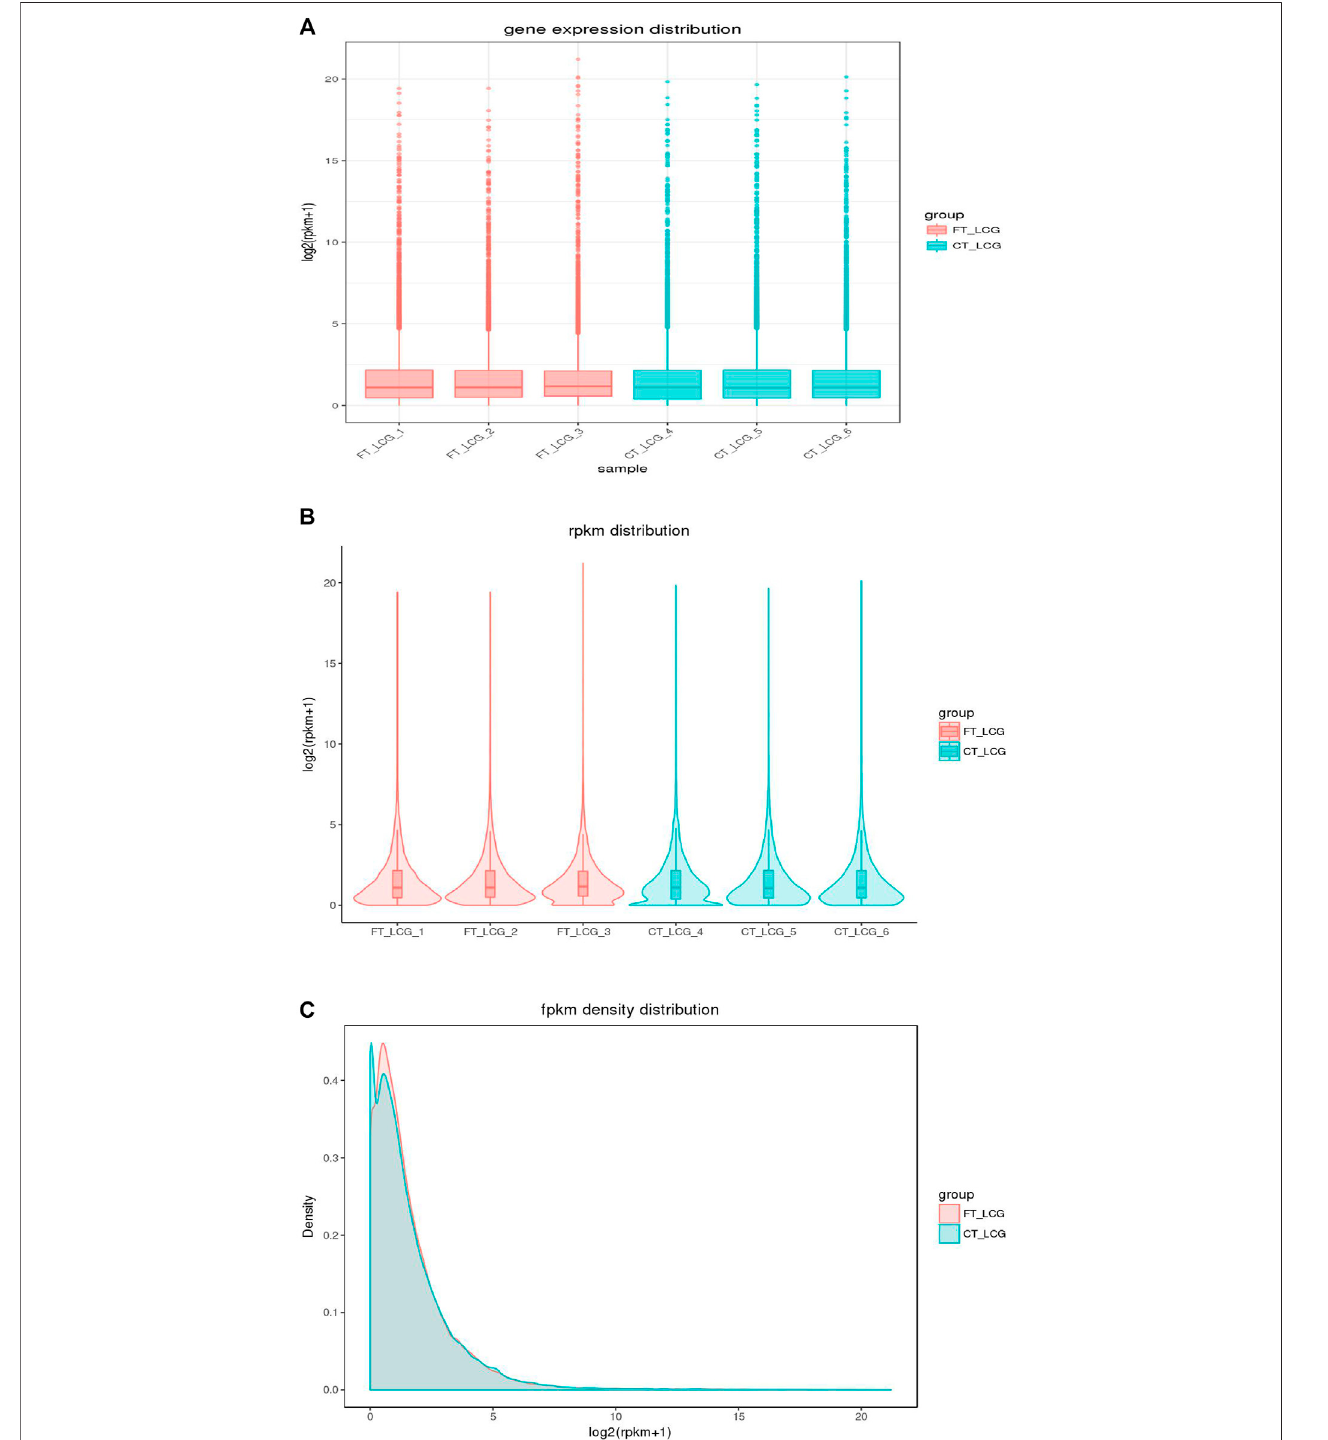
FIGURE 3 | Distribution of gene expression in fi ne and coarse type LCGs. The abscissa in the graph is the sample name, and the ordinate is log2 (RPKM+1). The fi ne LCG sample is shown in pink, and the coarse LCG sample is shown in blue. The box graph of each region has fi ve statistics (the maximum, upper quartile, median, lower quartile, and minimum from top to